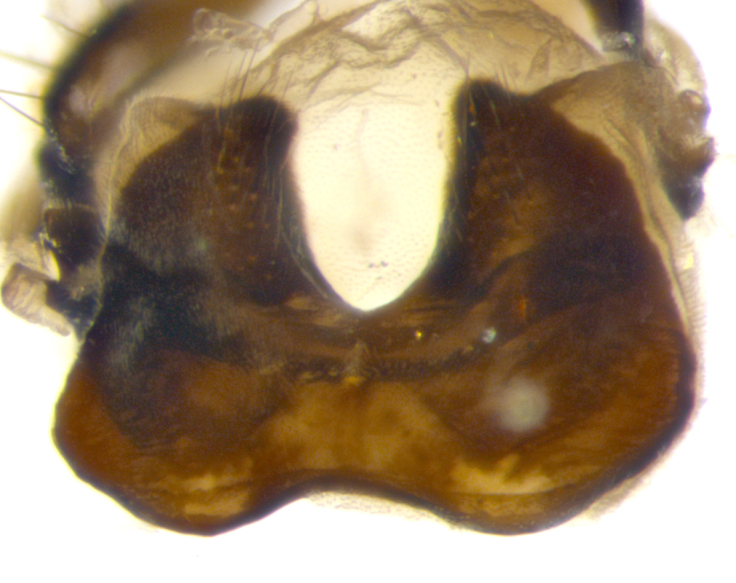
sternite 5, ventral view